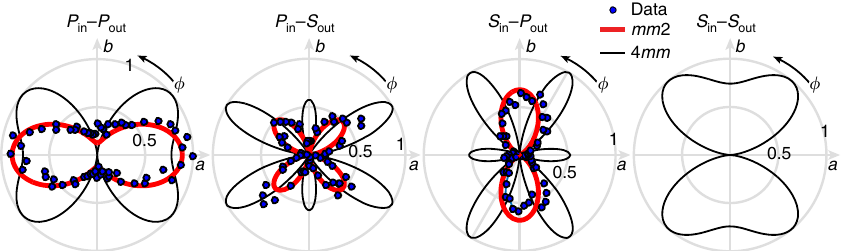
Fig. 1 SHG rotational anisotropy experiments. Polar plots of the SHG-RA data (blue dots) from the (100) surface of MAPbI 3 , where each panel shows results for a different set of incident and outgoing polarizations. The radial direction represents the normalized magnitude of the SHG intensity and the azimuthal angle ϕ the orientation of the light scattering plane relative to the tetragonal a -axis. The expected electric-dipole SHG radiation patterns from the bulk of a I 4 cm crystal (black) and best fi ts of the data to electric-dipole SHG radiation patterns from the surface of a I 4/ mcm crystal (red) are superposed on top of the data. In the latter case, SHG is forbidden by symmetry in S in − S of the ED induced SHG susceptibility tensor for the mm 2 and 4 mm point groups 33,35 .